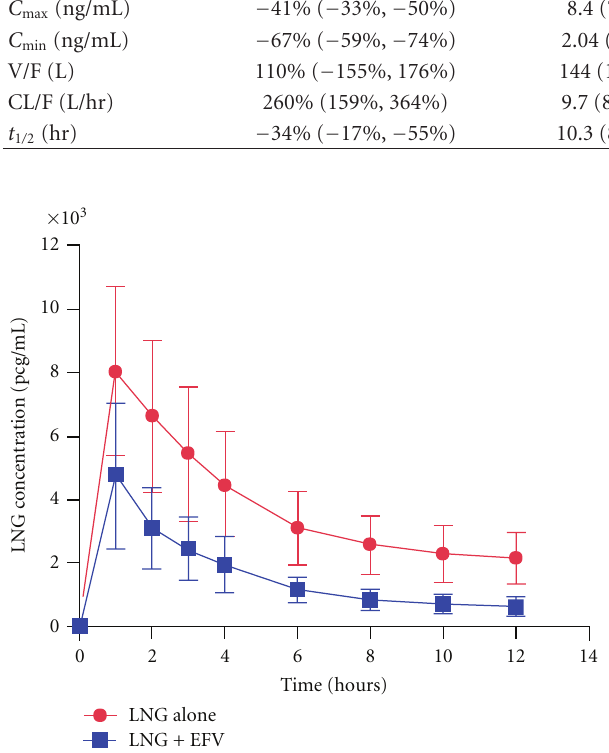
Figure 1: Mean plasma concentration versus time profile for LNG. Mean ( ± SD) levonorgestrel concentration-time profile in 21 healthy volunteers administered alone (red) and after 14 days of pretreatment with efavirenz